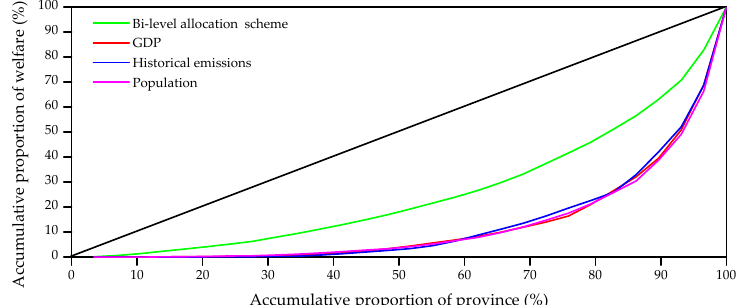
Figure 11. The Lorentz curve of welfare effect under target 1.